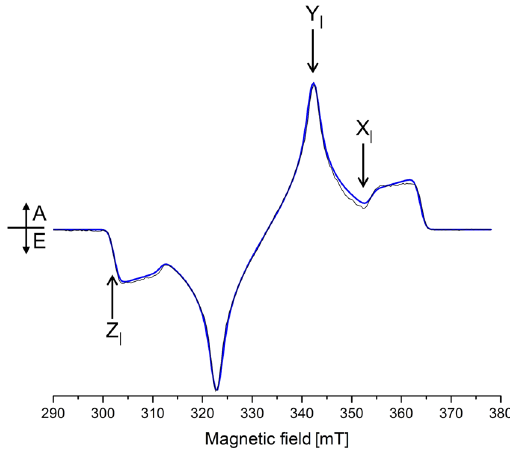
Figure 2. X-band TR-EPR spectrum of Chl a WSCP (black line), taken 150 ns after the laser pulse, at 130 K. Calculated spectrum (blue line) according to the parameters reported in Table 1. X, Y and Z represent the ZFS canonical orientations, only the transitions connecting the m s = 0 to m s = + 1 levels are highlighted.